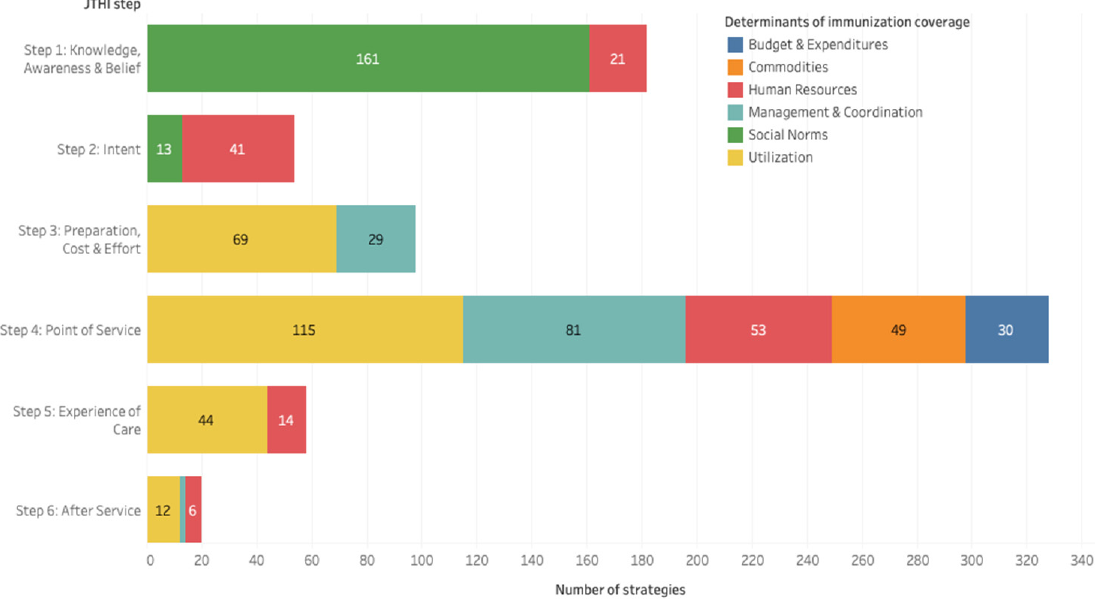
Figure 2. Relative proportion of strategies per JTHI step and determinant of immunization coverage. Moreover, nested within each step and determinant of immunization coverage, we consolidated strategies into 24 themes (see Figure 3).